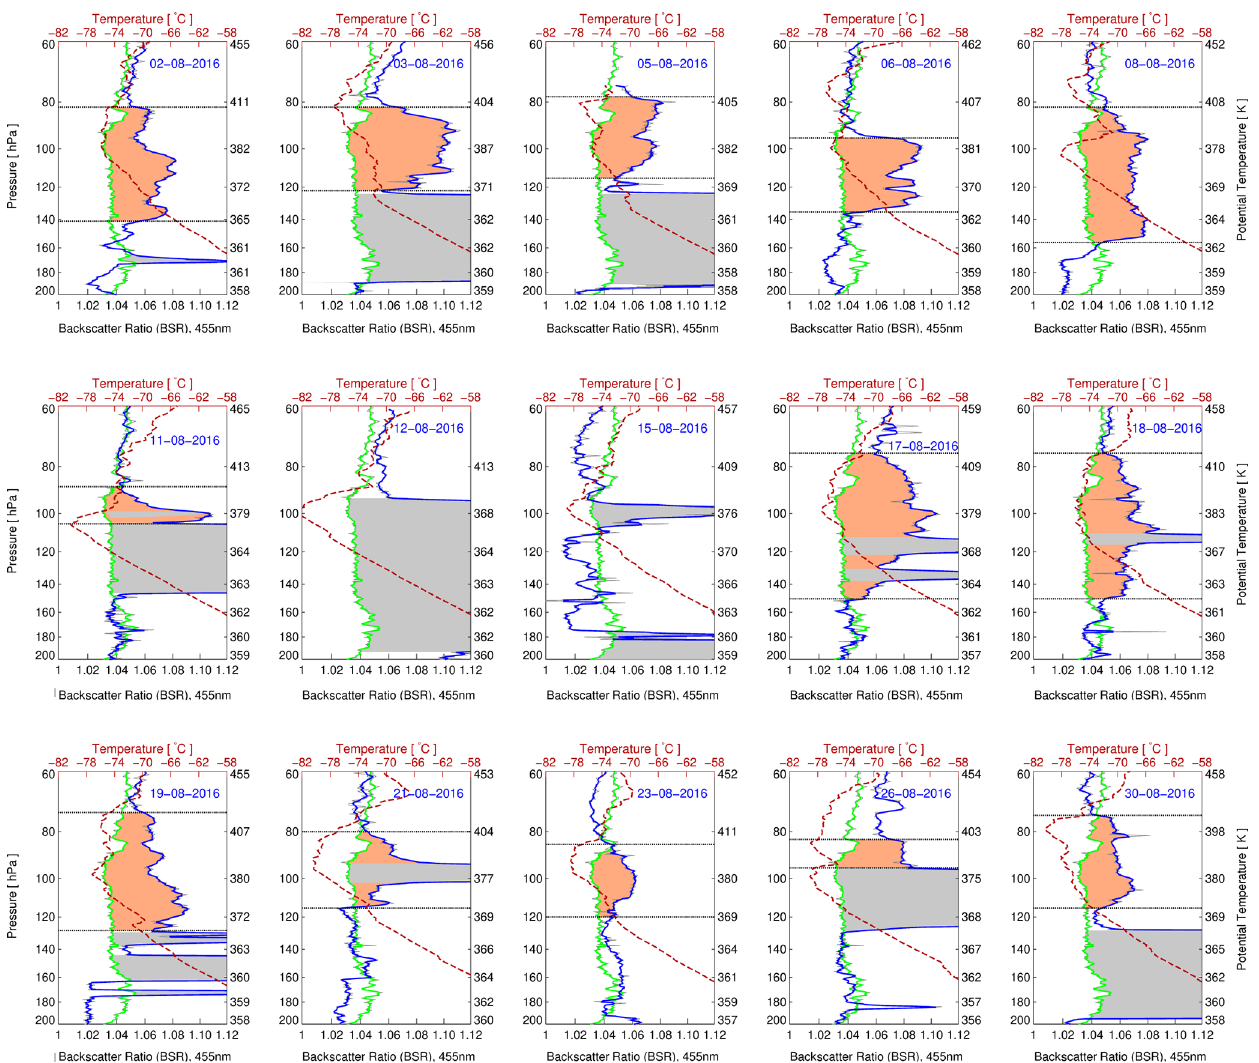
Figure 2. COBALD BSR 455 measurements in the UTLS region versus pressure (60–200hPa) for each flight in August 2016 (blue line). Corresponding potential temperature calculated using both measured pressure and temperature is also given for orientation (see right-hand y axis). The averaged BSR 455 profile of the two November measurements is shown in green. The blue and the green lines show a slightly smoothed representation (three-point smoothing) of the original 0.5hPa binned data (light grey lines; see Sect. 2.3 for details). The measured temperature for each day in August 2016 is shown in red. The ATAL is highlighted by the orange shading, and cirrus clouds are indicated by the grey shading. The top and bottom boundaries of the ATAL (see Table 1) are marked by horizontal dashed black lines, except for 12 and 15 August, as no ATAL was detected on these